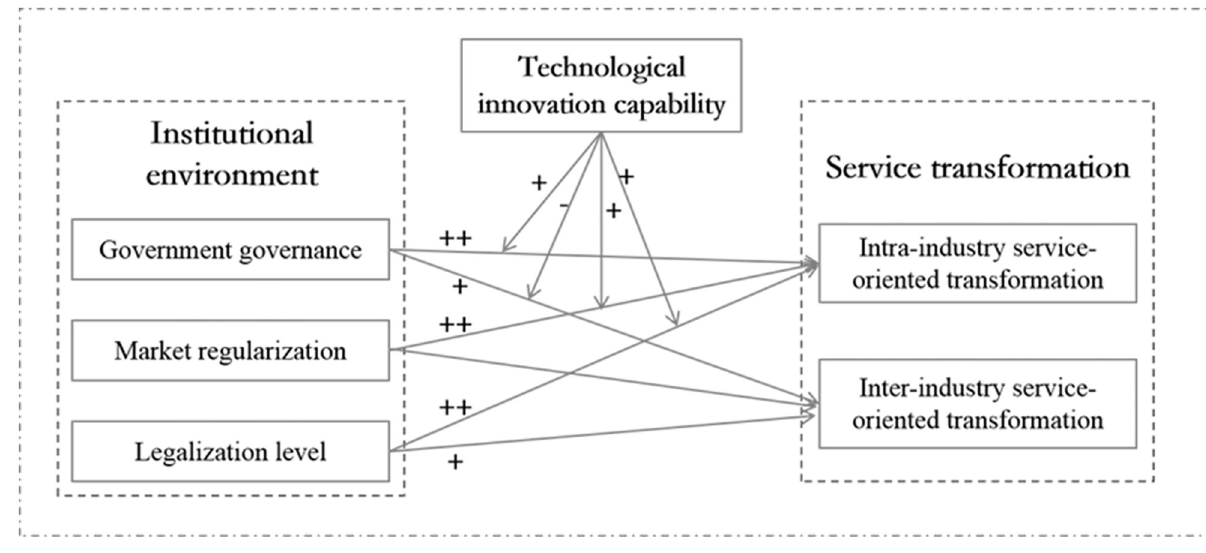
Fig 2. Empirical test